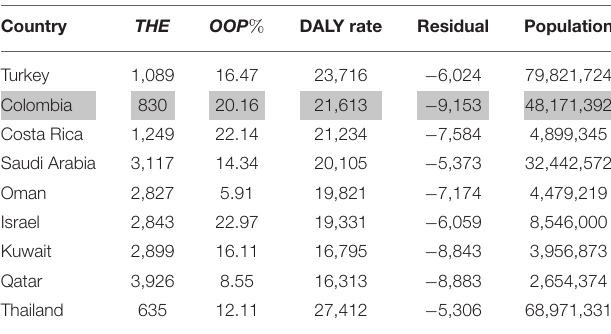
TABLE 4 | Pooled dominant (OOP < 25%) positive outlier countries.